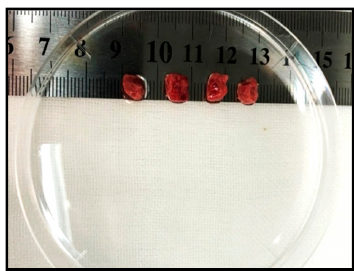
Figure 2. Fresh surgically resected mouse malignant tumor tissue ready to be transplanted.